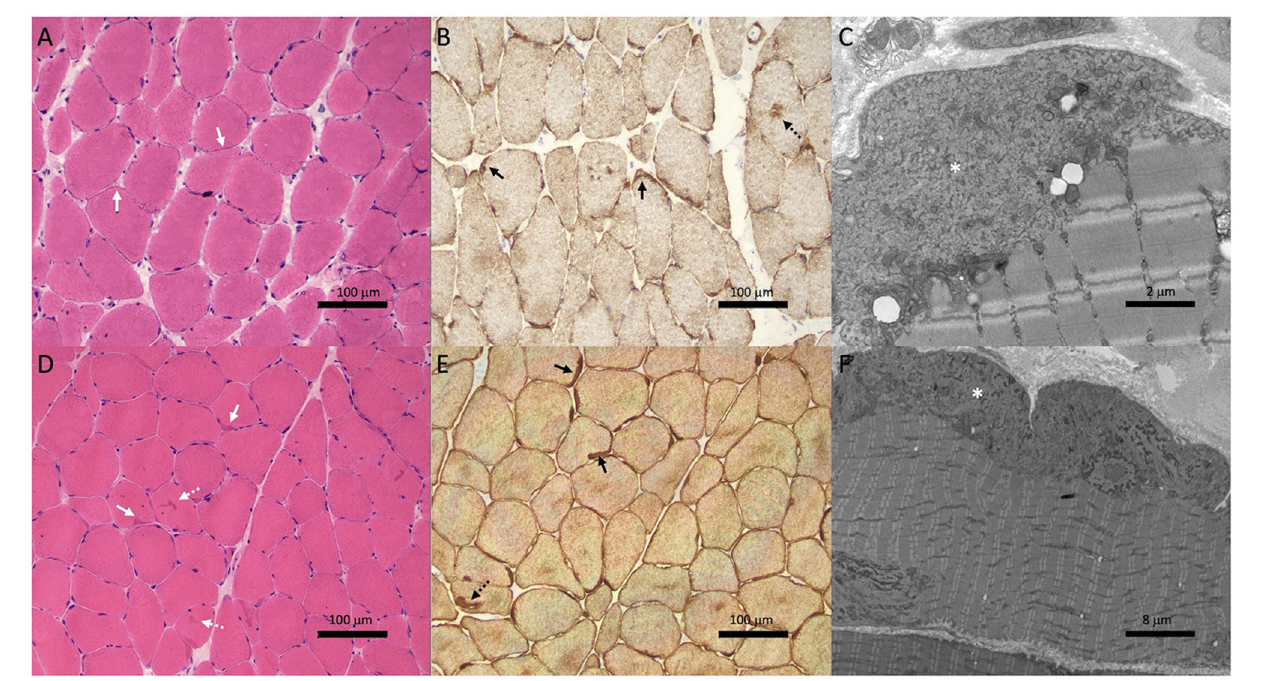
FIGURE2 Muscle biopsies from Case 1 (II-1; A – C ) and Case 2 (III-1; D – F ) showed features of myofibrillar myopathy. Hematoxylin & eosin staining (A, D) showed subtle subsarcolemmal (solid white arrows) and central basophilic hyaline inclusions (dotted white arrows). Variation in muscle fiber size is also noted in